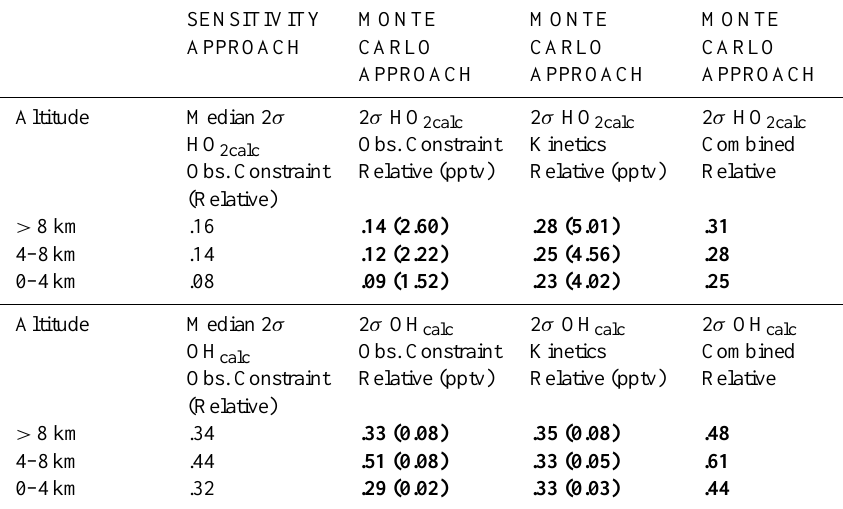
Table A3. 2 σ Uncertainty in model predictions for ARCTAS-B (Fully constrained Model).